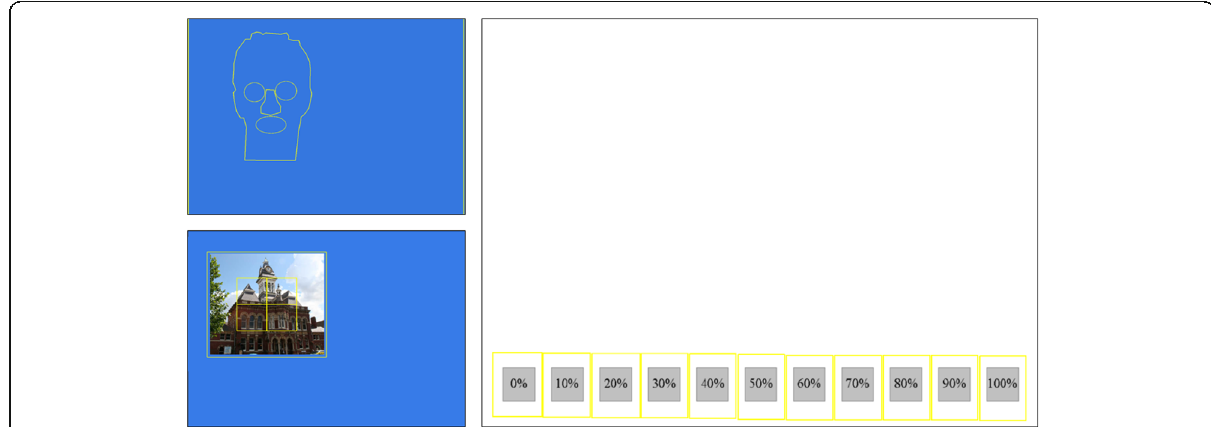
Fig. 2 Interest areas defined: face (Experiment 1), non-face item (Experiment 2), confidence screen (Experiments1, 2) Photograph of actual person not shown as permissions not